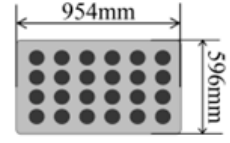
Figure 2. Cultivation unit.